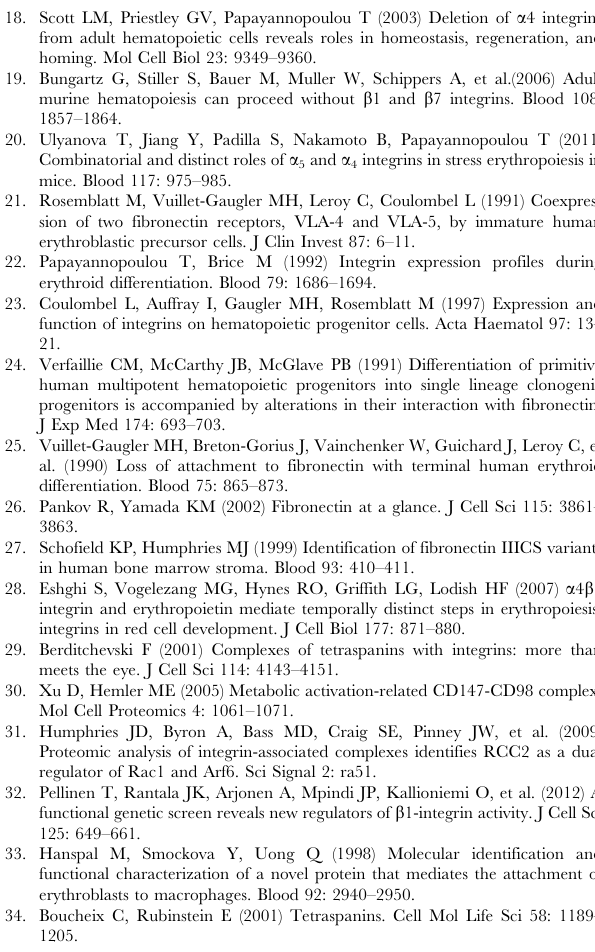
Figure S5 Effect of antibodies to b 1 and tetraspanins on the binding of erythroblasts to Vascular Cell Adhesion Molecule-1. Box-Whisker plots of normalized values (calculated from the average value of isotype control cells bound) of each data point from all experiments performed at three stages of maturation, with the median, 10 th , 25 th , 75 th and 90 th percentiles depicted as vertical boxes with error bars. *, P , 0.001, **, P , 0.050; ***, P= 0.051, compared with the relevant isotype control values for each clone as determined by one way analysis of variance (which is a subset of all control values depicted at each time point). All antibodies were tested at each time point at least three times except for CD82 423524 (twice on days 5 and 8, once on day 12) and CD81 1D6 (once on day 12). Coating 0.25 m g/ml for ProEB, BasoEB and PolyEB, respectively. Figure S6 Effect of antibodies to b 1 and tetraspanins on the binding of erythroblasts to fibronectin fragment FnIII 12-IIICS-15 . Box-Whisker plots of normalized values (calcu- lated from the average value of isotype control cells bound) of each data point from all experiments performed at three stages of maturation, with the median, 10 th , 25 th , 75 th and 90 th